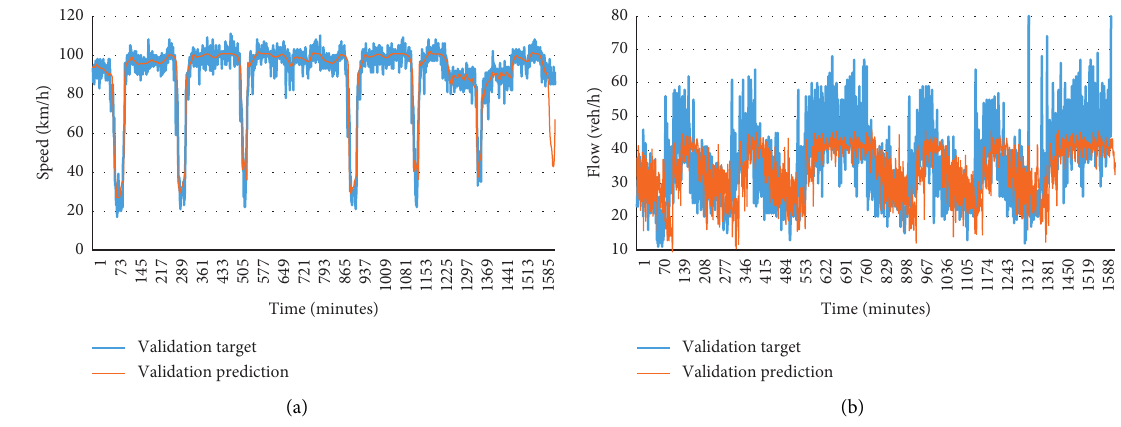
Figure 14: Speed and flow validation results for 30